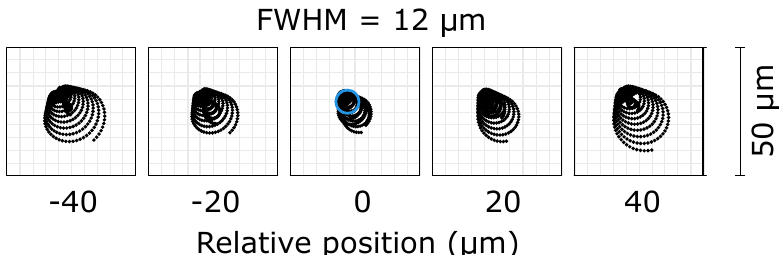
Figure 10. Footprints around focal spot of Schwarzschild in steps of 20 mm. Full width at half maximum (FWHM) of the central one corresponded to 12